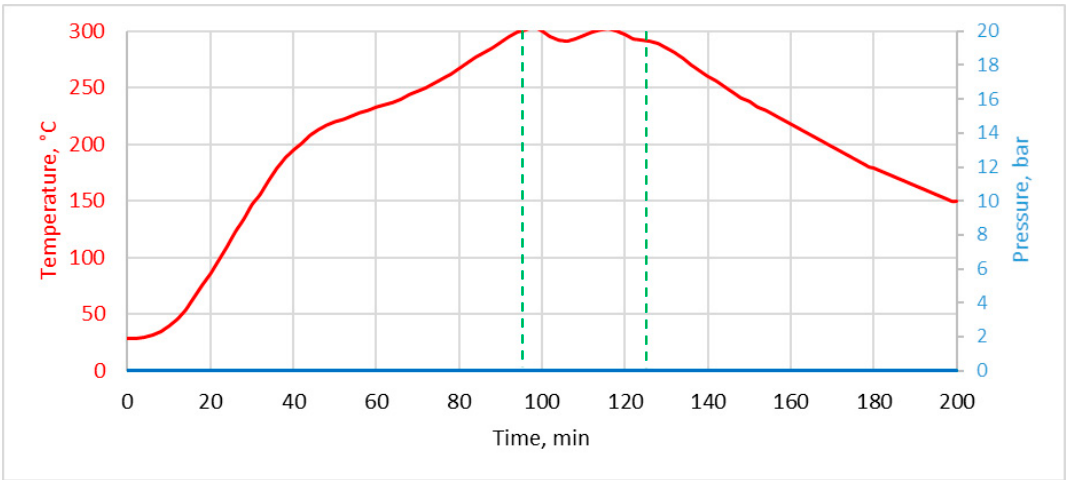
Figure 4. An example of temperature patterns during the atmospheric torrefaction (ap), green dashed line stands for start and end of the torrefaction process (30 min).